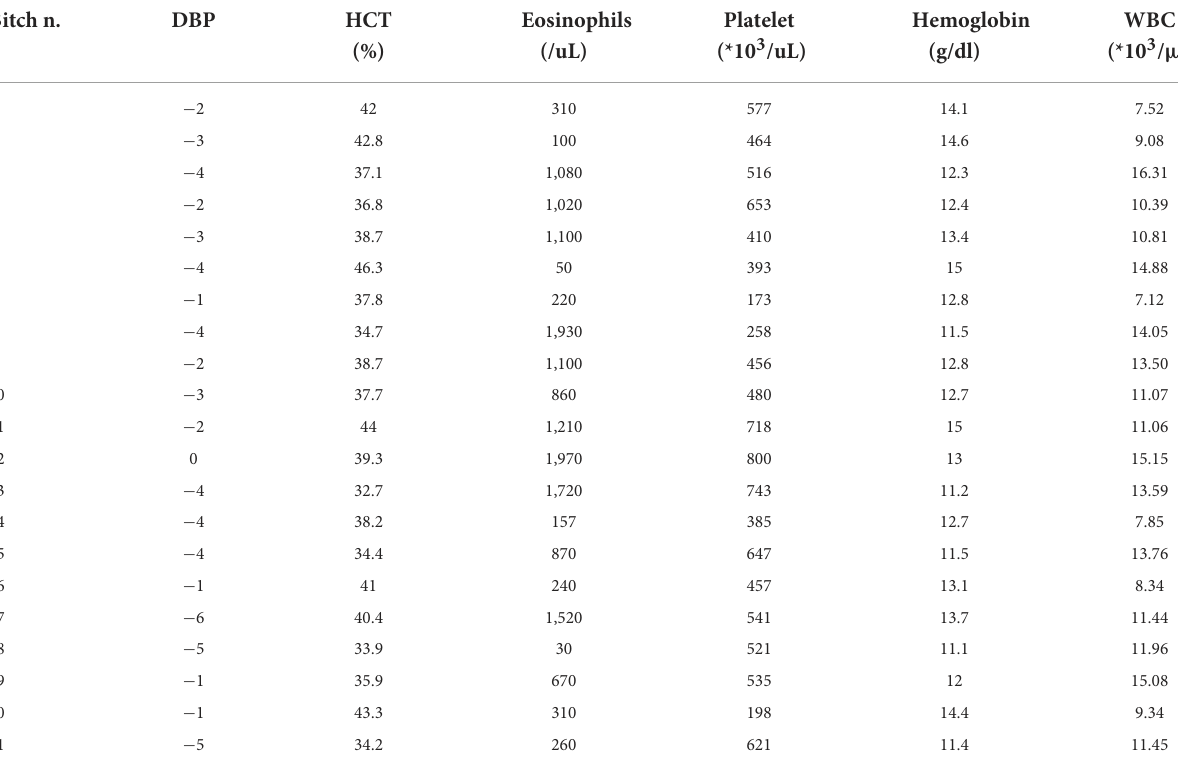
TABLE 3 Cell blood count results: Bitch identification number ( n .), days before parturition (DBP) in which the exam was performed, hematocrit (HCT, normal range of 38–49.5%), eosinophils (normal range of 130–530/uL), platelet (normal range of 211–384 * 10 3 /uL), hemoglobin (normal range of 13.3–17.2 g/dl), and white blood cells (WBC) (normal range of 8.53–16.61 * 10 3 / µ l). Bitch